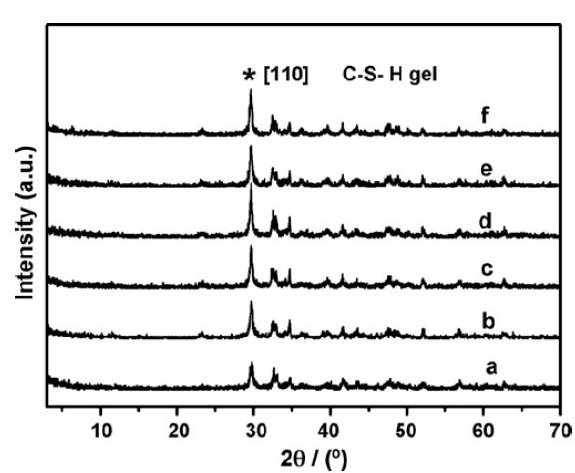
Figure 5. In situ XRD patterns of cement mortar (a) without and (b–f) with LDHs additives after different aging times: (b) 6 min; (c) 1 d; (d) 3 d; (e) 7 d; (f) 28 d. Symbol of * shows the